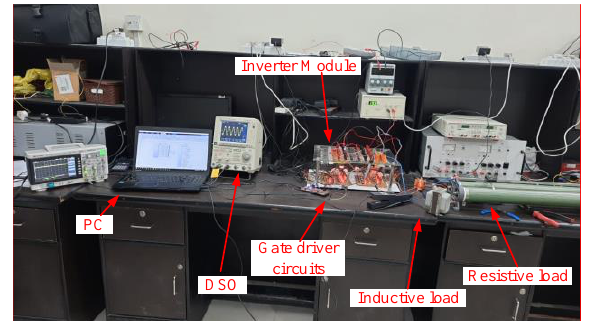
Figure 8. Experimental Prototype.